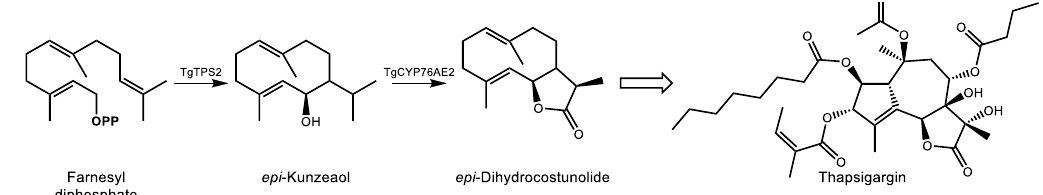
Figure 7. Initial biosynthetic steps for the formation of the sesquiterpene lactone thapsigargin in T. garganica . Enzyme abbreviations are as follows: TgTPS2 – epi -kunzeaol synthase, TgCYP76AE2 – cytochrome P450 76AE2. OPP signifies a diphosphate moiety. The open arrow indicates